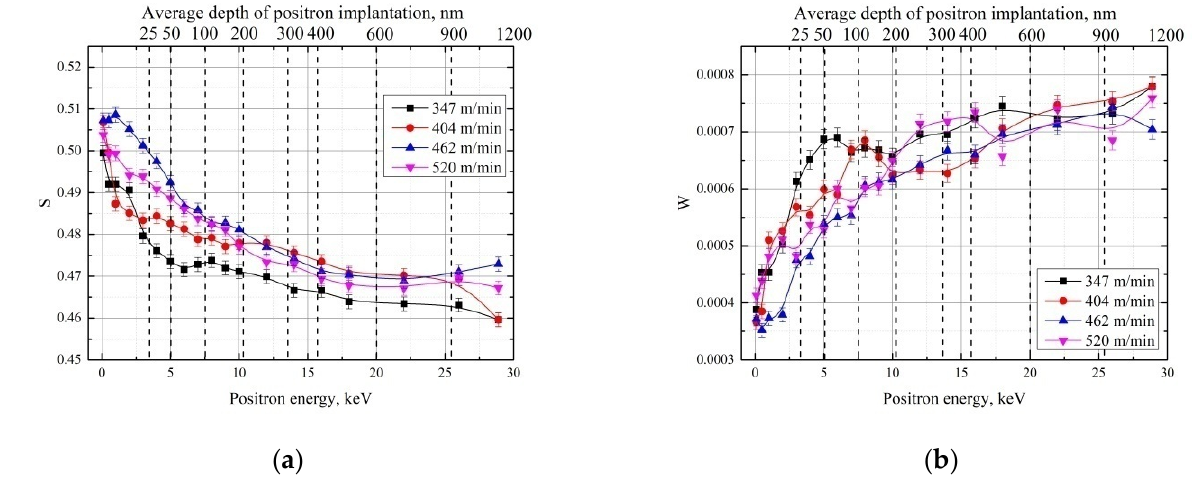
Figure 4. DBS-VEP depth profile of the S ( a ) and W ( b ) parameters for the white layer in GCr15 steel samples with different cutting speeds.